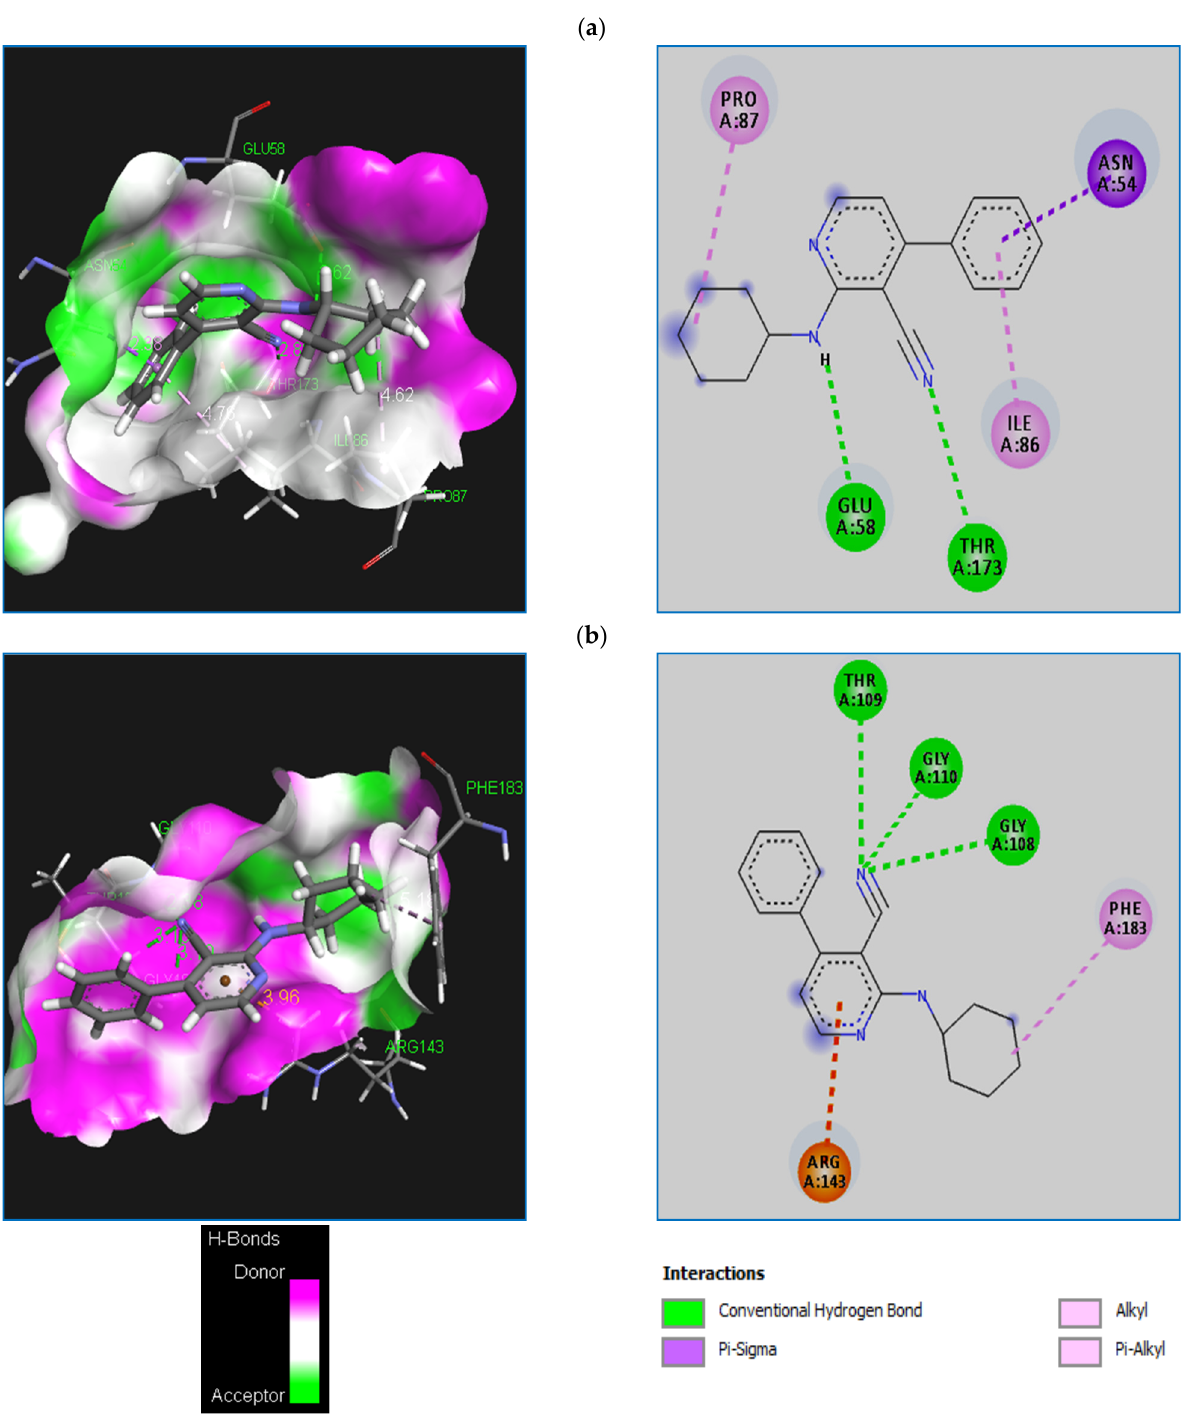
Figure 3. 2D and 3D Binding Pose and the Interaction of Compound 2c with: ( a ) the active site residues of S. aureus (PDB ID: 4URM), ( b ) the active site residues of B. subtilis (PDB ID:2RHL).